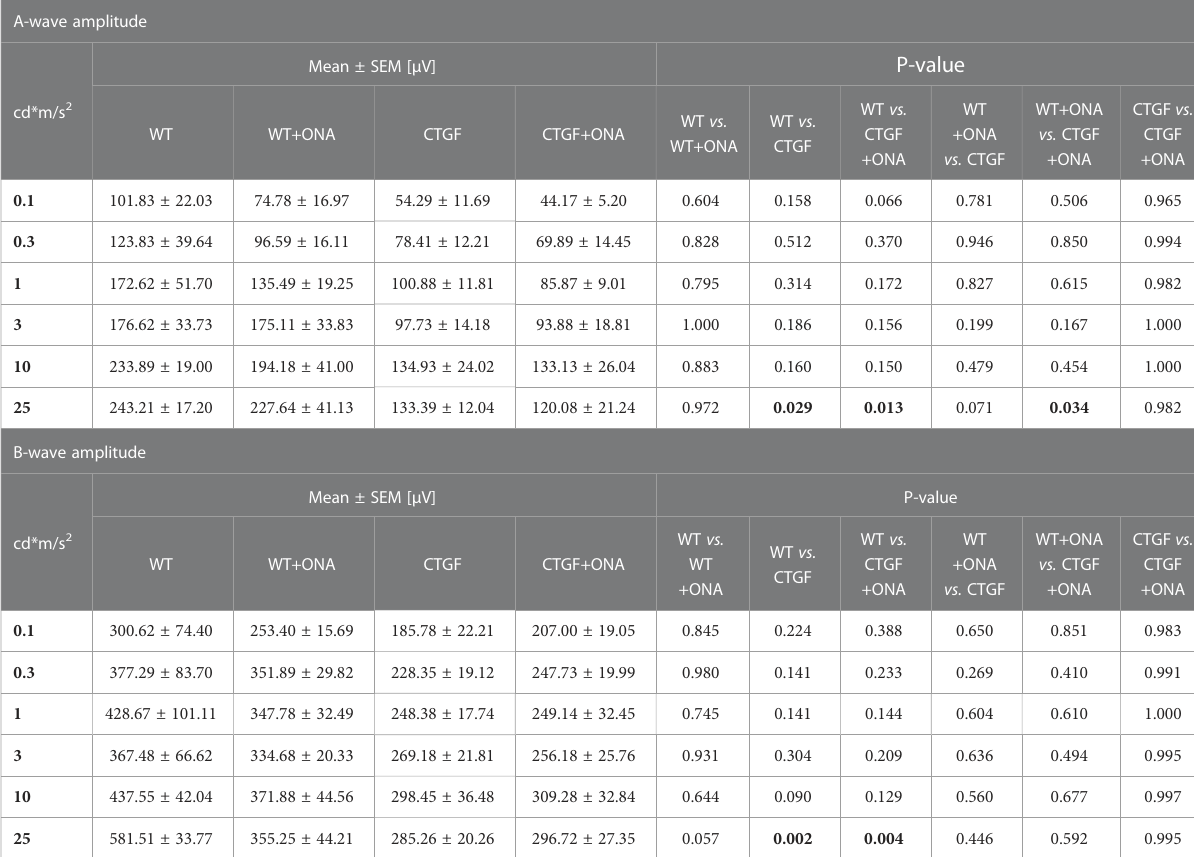
TABLE 4 Summary of ERG